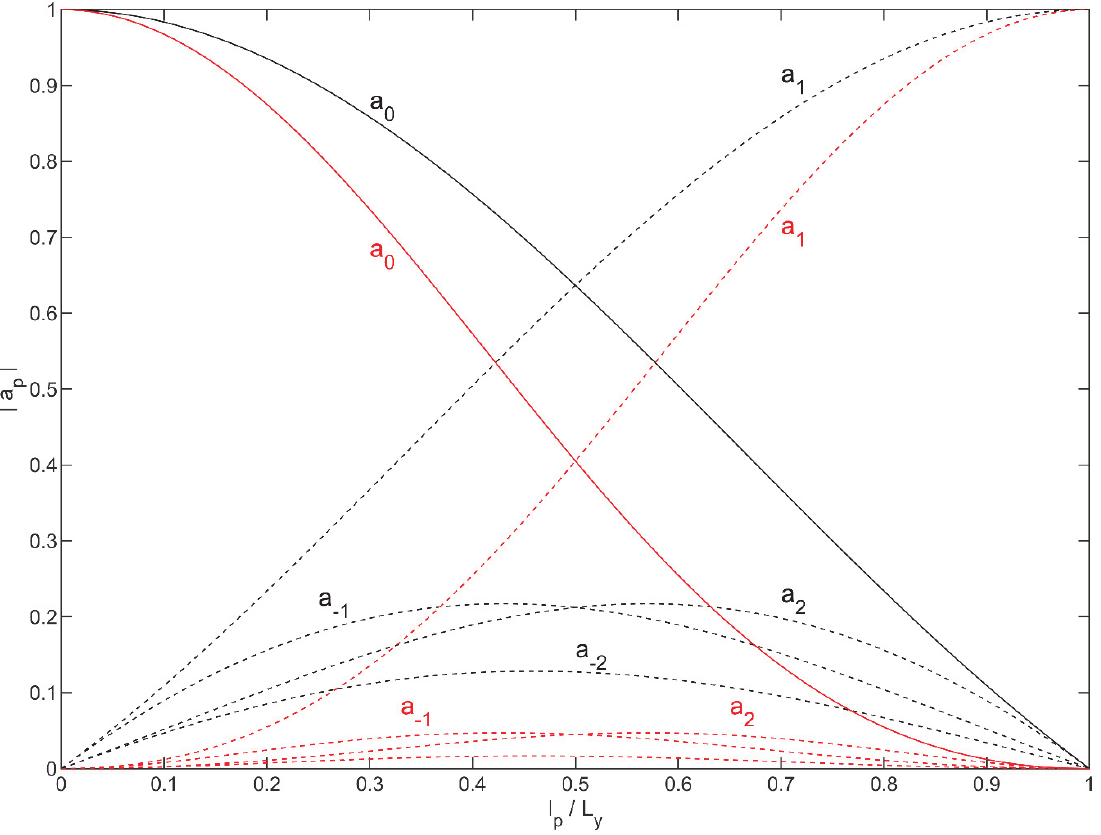
Figure 2. Amplitudes of components in Equation (16) for p = 0, ±1 and ±2 as function of segment width ( l p ) relative to the wavelength along the wavemaker ( L y = L / sin θ ) for box-mode (black) and vertical ( l p ) relative to the wavelength along the wavemaker ( L y = L /sin θ ) for box-mode (black) and vertical hinged (red) hinged (red) segmentation.